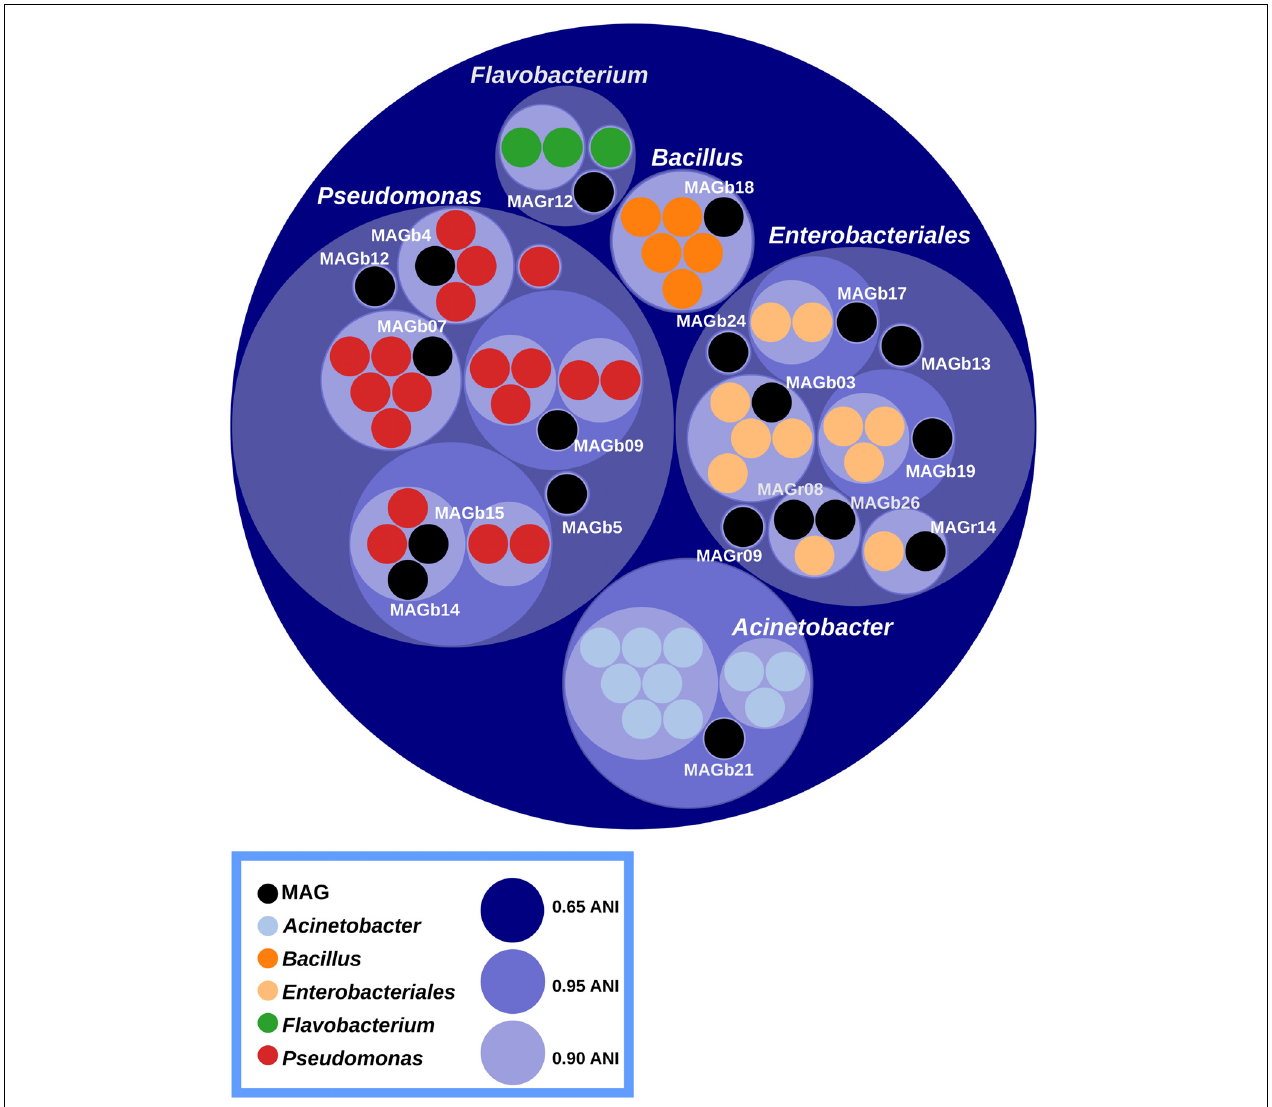
FIGURE 5 | Circle packing visualization of ANIb values. MAGs (black circles) and closely related genome sequences (colors circles) have been clustered according to their ANIb values. Inner and outer circles represent ANIb values at a cutoff of 0.65, 0.90 and 0.95 respectively. Although, Acinetobacter belong to the Pseudomonadales order, the ANIb cut-off chosen placed the genus outside this order. A total of 10 MAGs could be considered as new bacterial